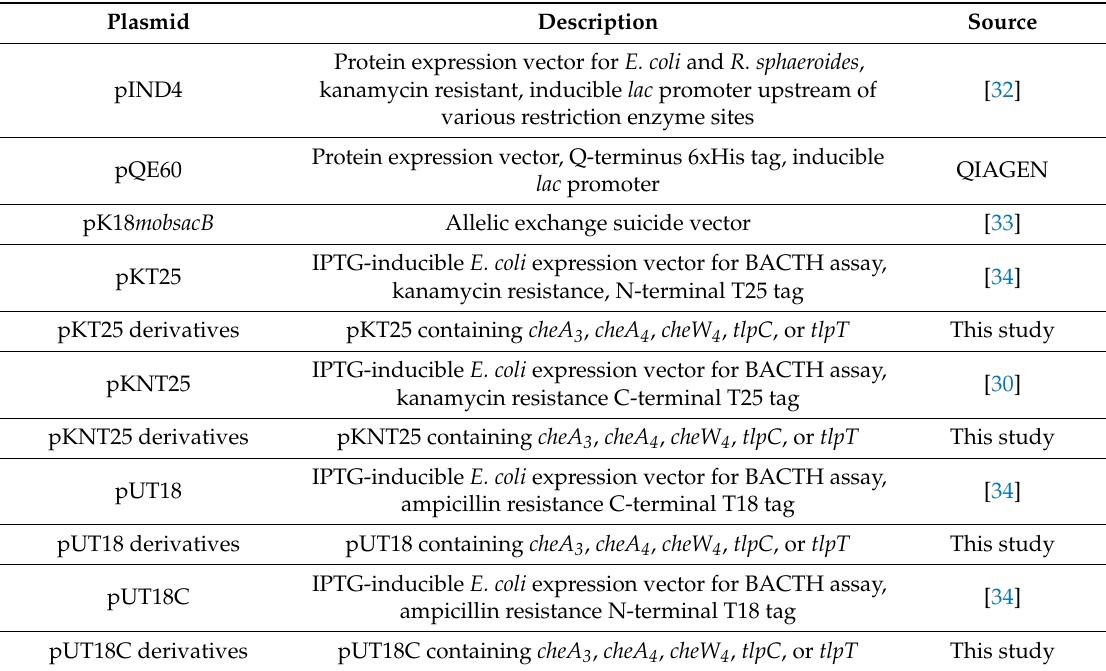
Table 5. Plasmids used in this